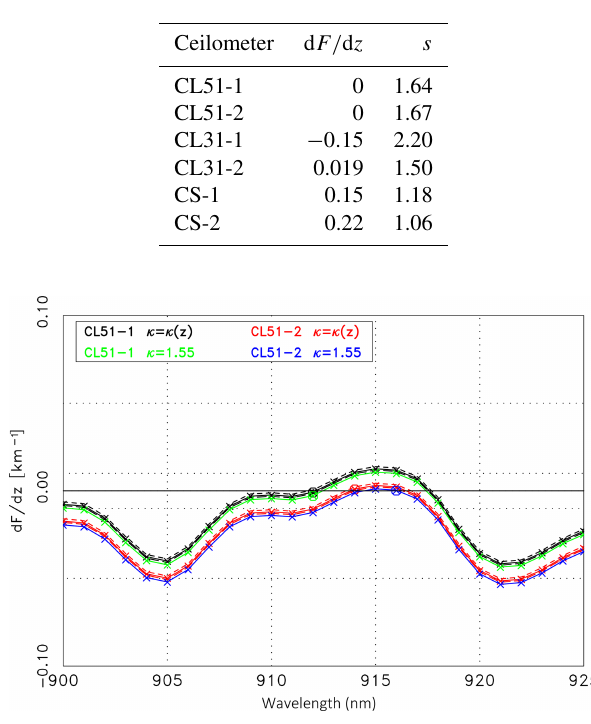
Table 6. Relevant criteria of the validation for Case C. The mini- mum slope d F/ d z for an integer wavelength is given, or d F/ d z = 0 if the corresponding curve shown in Fig. 12 crosses the zero line (for an noninteger wavelength). According to Eq. (17) the decrease in the range-corrected signal s should be 1 . 46 < s < 1 . 72.